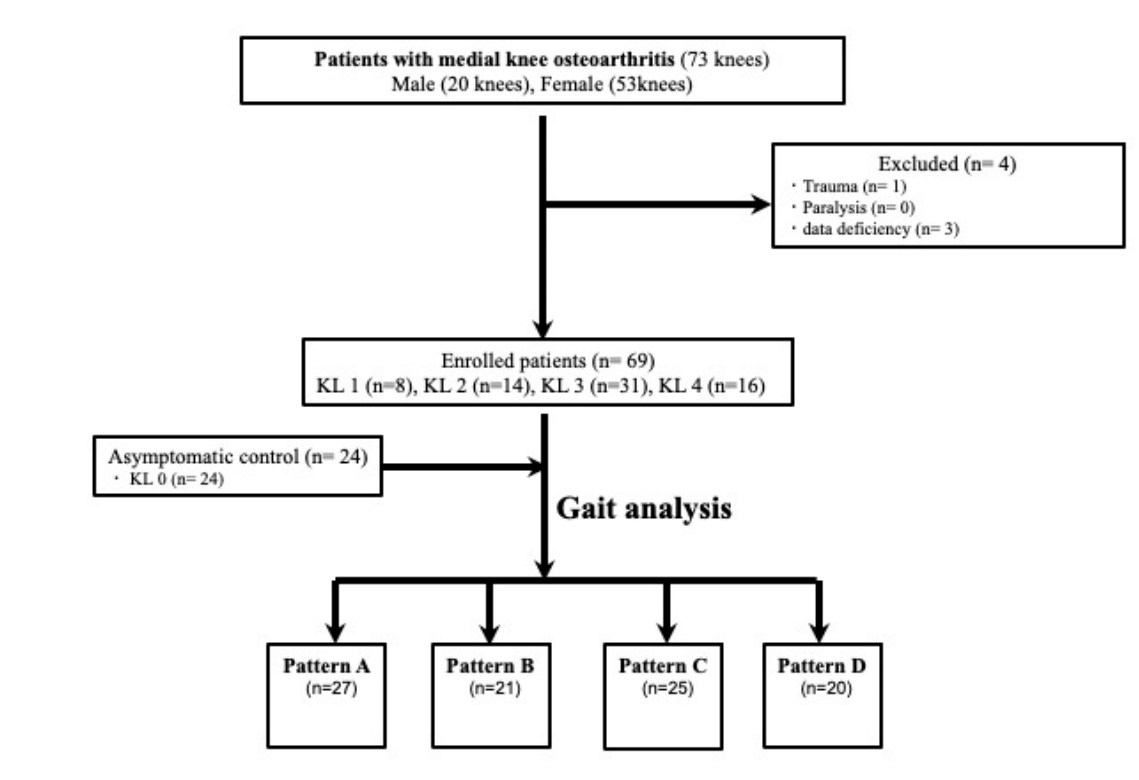
Figure 4. Flow chart showing the enrolled subject distribution. Table 1. Demographic data and measured variables for each clinical phenotype.